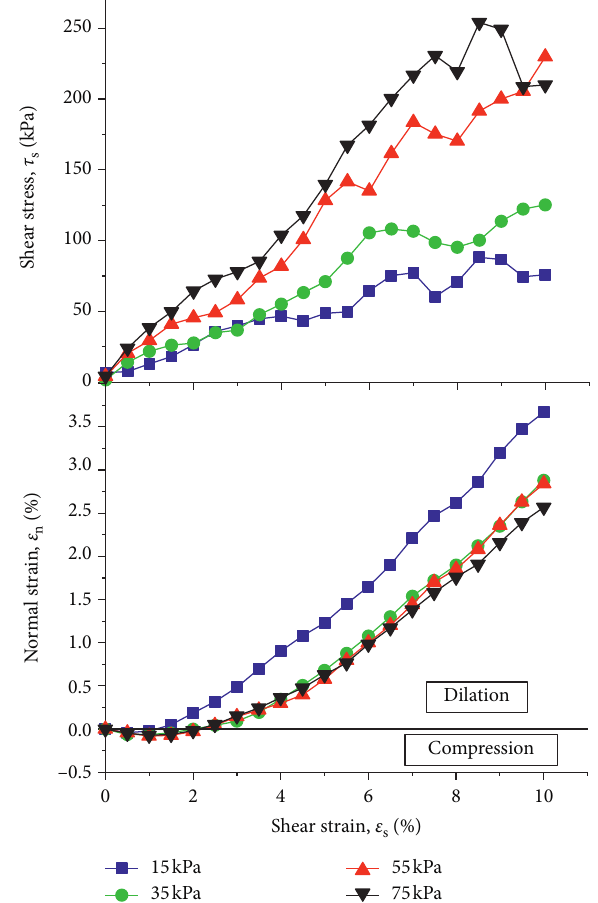
Figure 5: The shear stress and normal strain of ballast aggregates under various normal